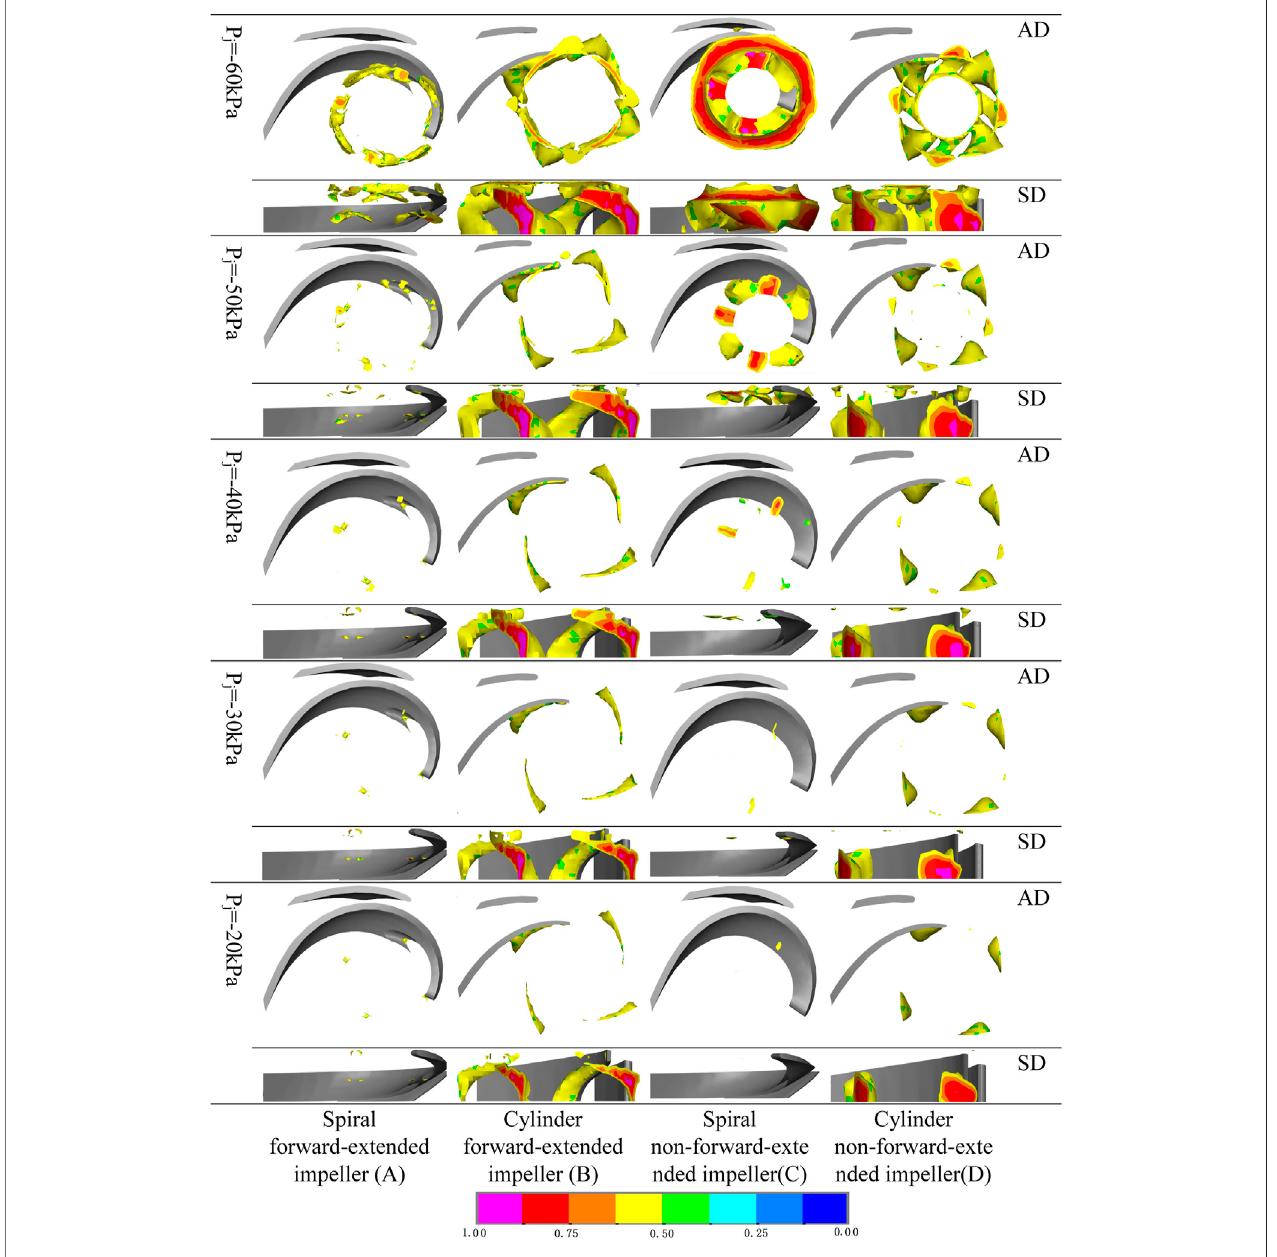
FIGURE 10 | The distribution cloud diagrams ofgas-phase volume fractions of different types of pumps at different inlet negativepressures under the design fl ow. (A) Spiral forward-extended impeller (B) Cylinder forward-extended impeller (C) Spiral non-forward-extended impeller (D) Cylinder non-forward-extended impeller.